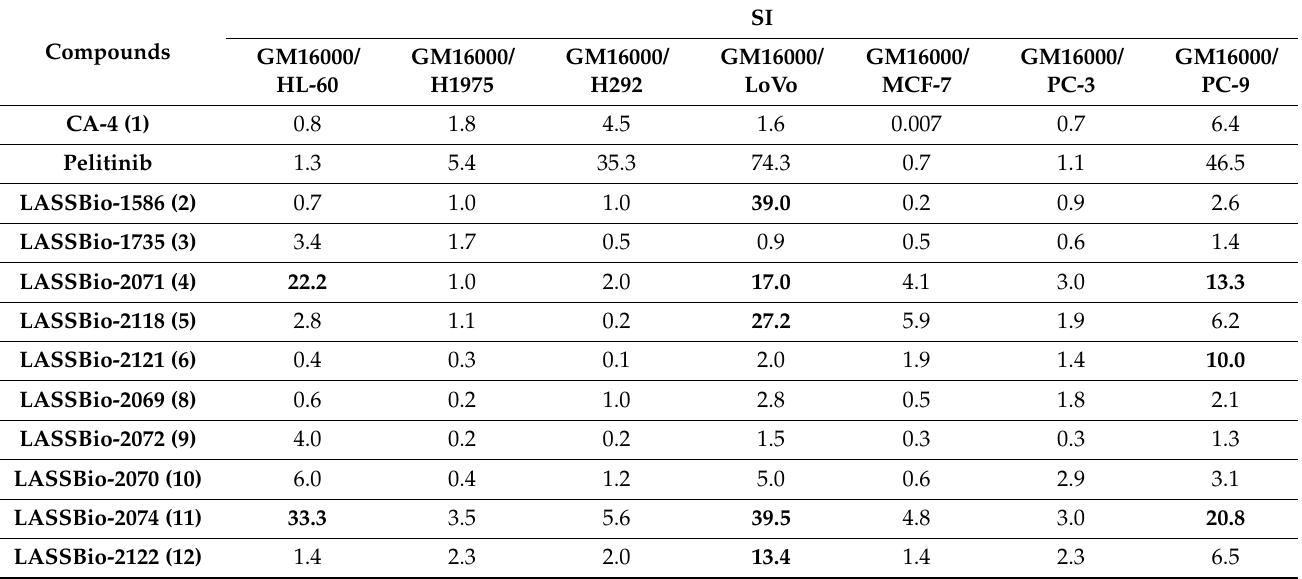
Table 3. Cytotoxic selectivity index (SI) of CA-4, pelitinib, LASSBio-1586 and its homologs 3 – 12 at 72